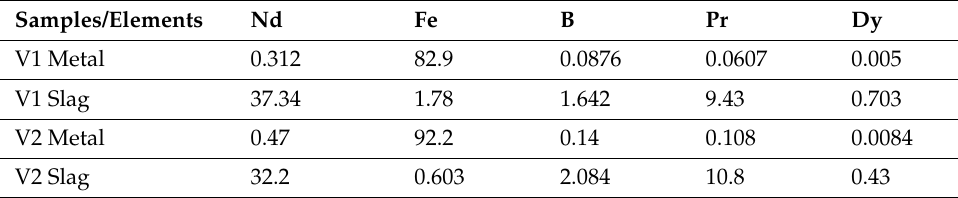
Table 7. ICP-OES analysis of smelting product (%) .